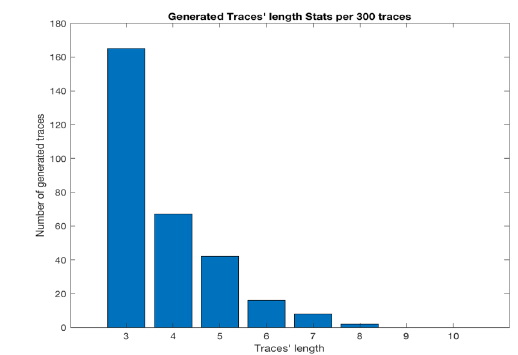
Figure 8. Generated banking traces’ length per 300 traces.